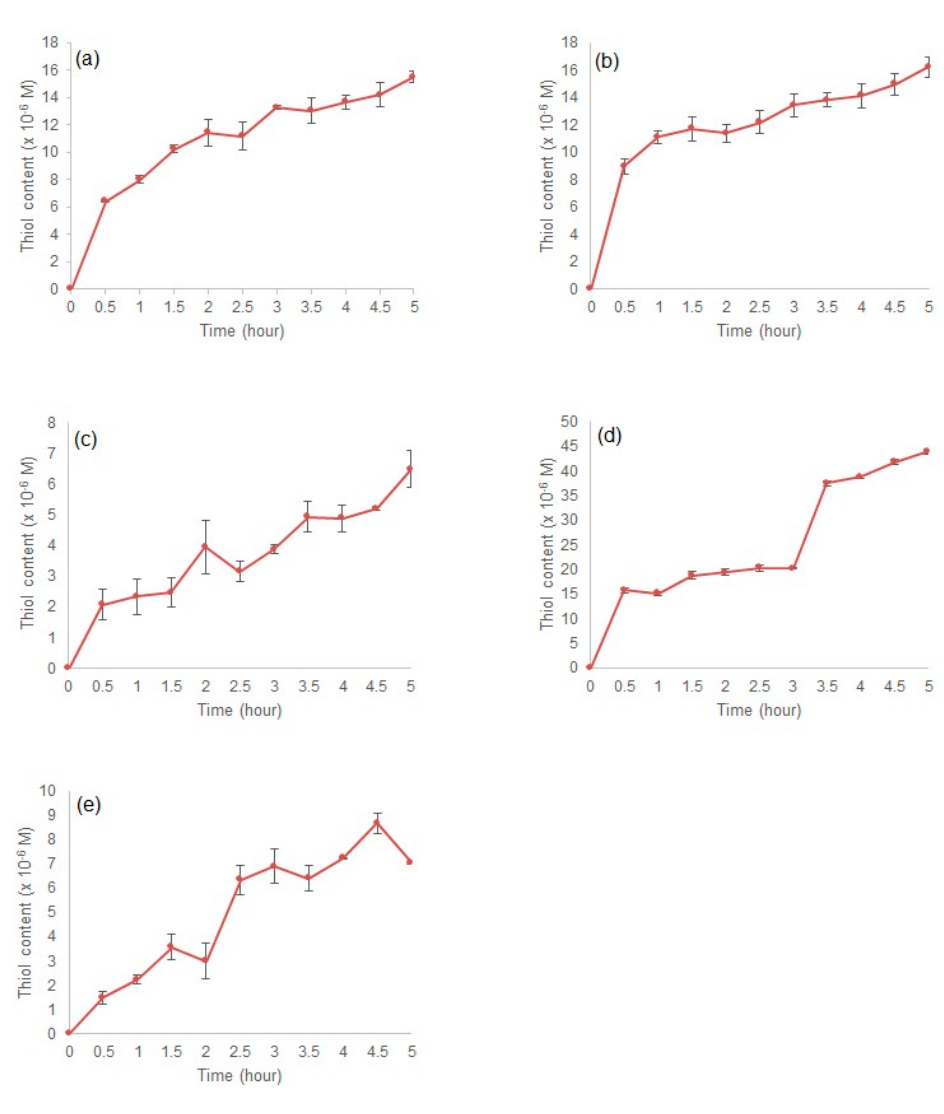
Figure 7. Thiol concentration in simulated gastric and intestinal conditions for polymer ( a ) P10, ( b ) P15, ( c ) P21, ( d ) P25, and ( e ) P51.